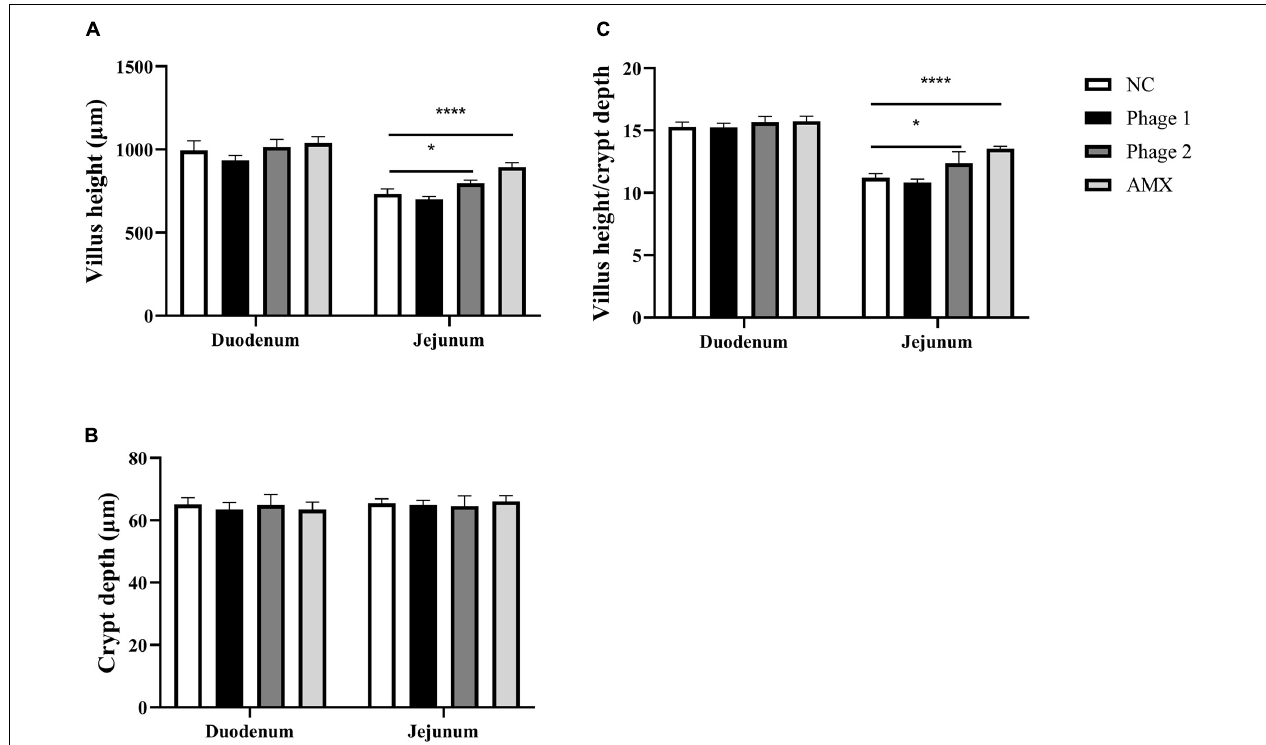
FIGURE 2 | Effect of phages on (A) villus height, (B) crypt depth, and (C) villus height to crypt depth ratio of the duodenum and jejunum of chicks in the NC, Phage 1, Phage 2, and AMX groups, respectively. Values are means (n = 5). NC, negative control; Phage 1, 10 9 PFU GRNsp6 (day 3-5); Phage 2, 10 9 PFU GRNsp6 (day 8-10); AMX, 1 mg/ml amoxicillin (day 8-10). * p < 0.05; **** p < 0.0001.